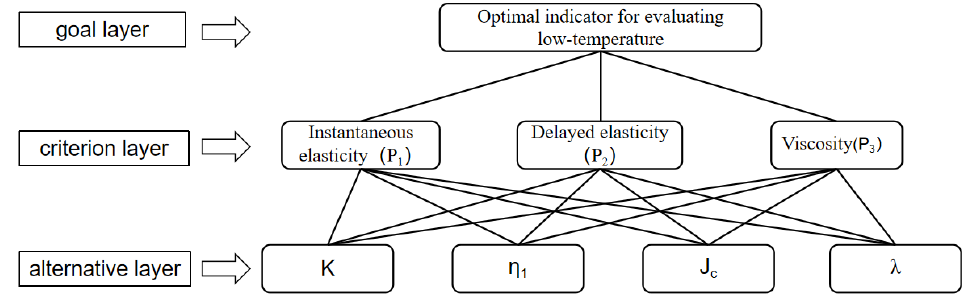
Figure 18. The AHP analysis process.